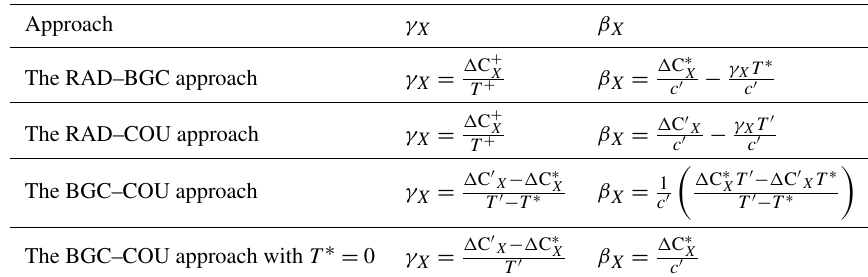
Table 1. The values of the carbon–concentration ( β ) and carbon–climate ( γ ) feedback parameters can be solved using results from any two combinations of the RAD, BGC, and COU versions of an experiment as shown in Eq. (1). In addition, when using results from the BGC and COU simulations, the effect of temperature change in the BGC simulation ( T ∗ ) can be neglected, as it was in the F06 study, yielding approximate values for β X and γ X